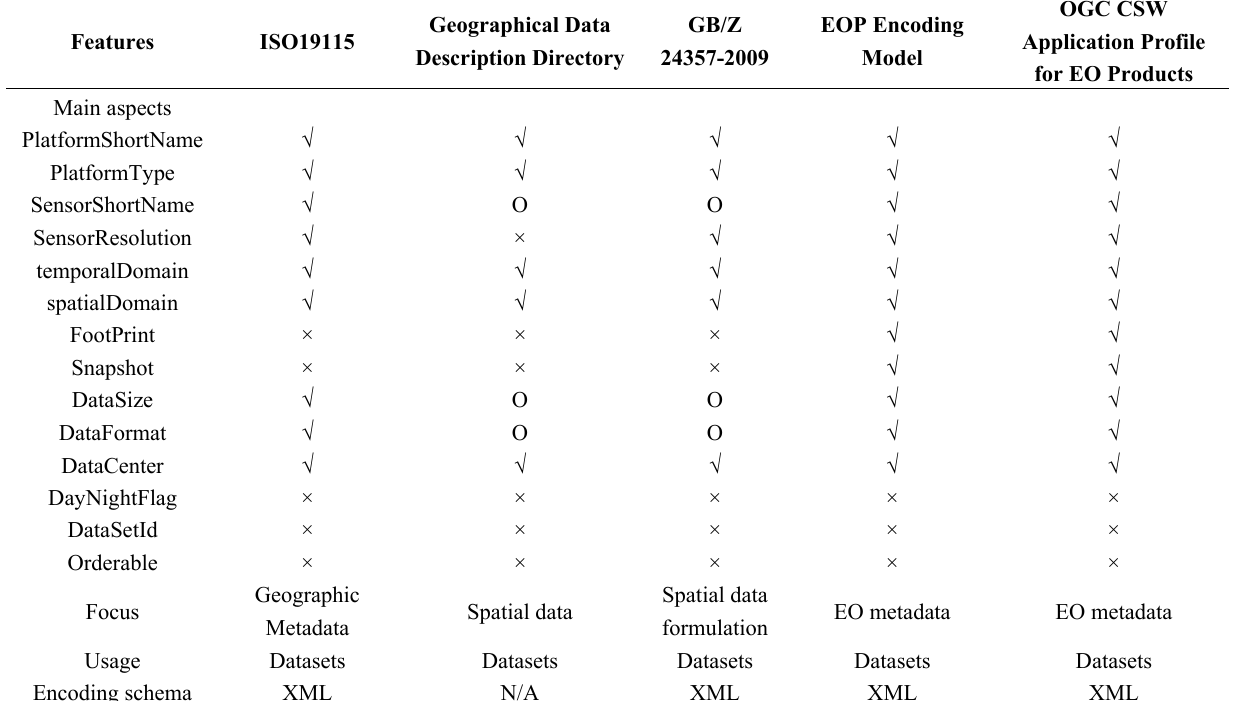
Table 3. Feature comparison of several EO encoding standards. OGC, Open GIS Consortium; CSW, Catalog Service for the